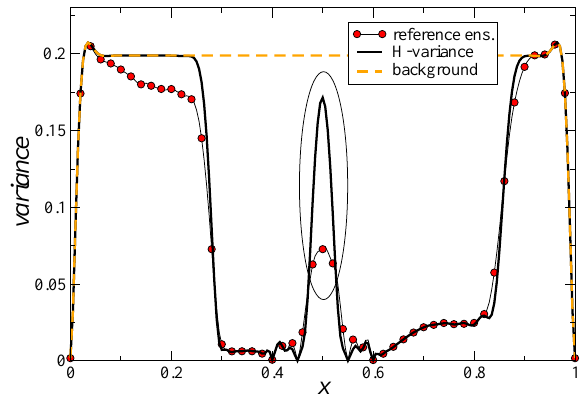
Fig. 1. Reference variance, variance by the inverse Hessian and background variance.